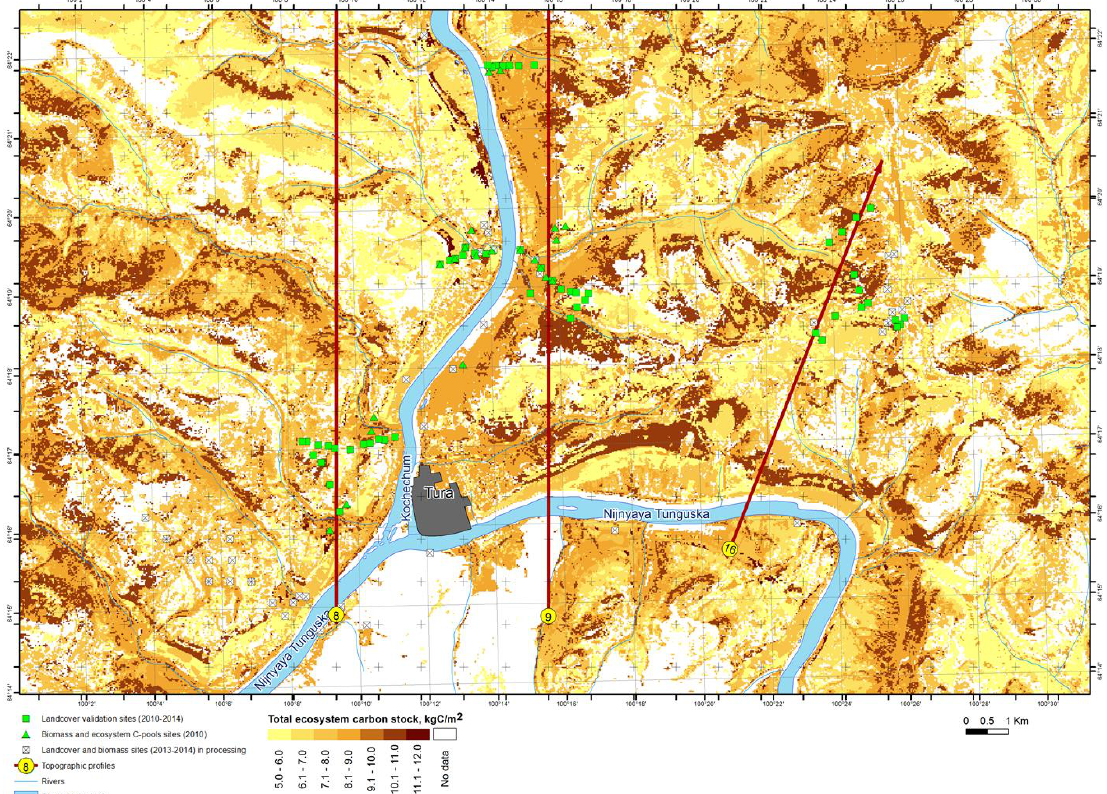
Figure 6. Total ecosystem carbon stock map for the fragment of the test